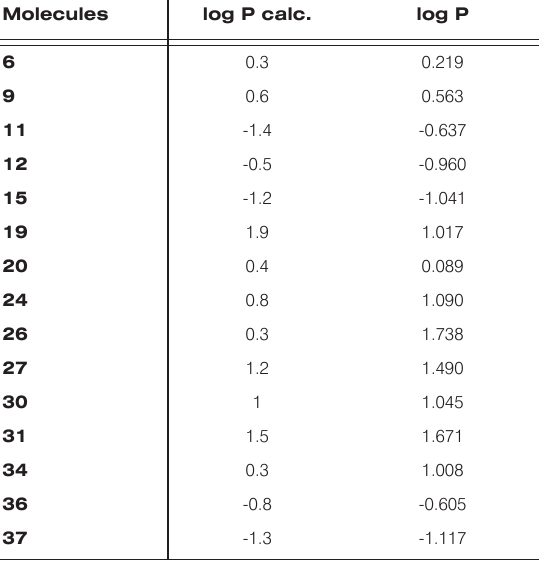
Table 12. Calculated values of log P for the molecules in the test set (Table 1). Molecules log P calc.